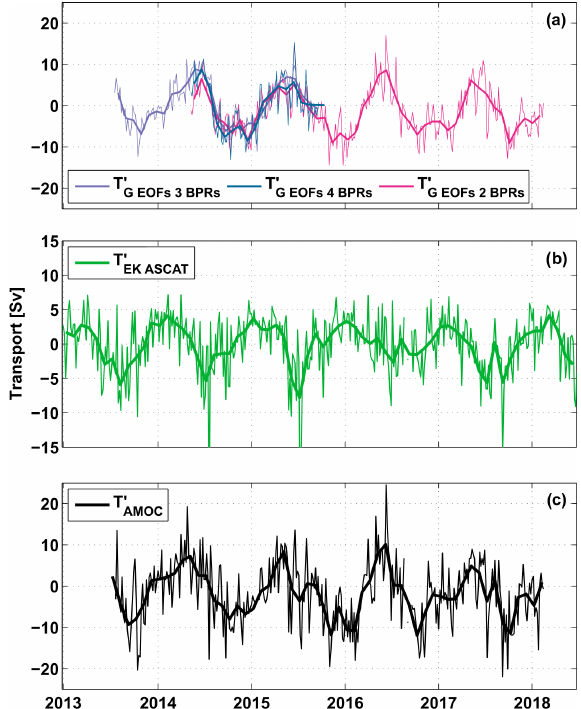
Figure 8. Anomaly time series at 11 ◦ S of (a) the upper-ocean ) , (b) the Ekman transport derived geostrophic transport ( T (cid:48) GEOFs ) and (c) the resulting AMOC from ASCAT wind stress ( T (cid:48) EKASCAT ) . Thin lines represent daily values in panel (a) transport ( T (cid:48) AMOC and 5d values in panels (b, c) ; bold curves represent monthly av- erages. Different colours in panel (a) indicate transport calcula- tions for different sets of BPRs – four BPRs (petrol), three BPRs (500m WB, 300m EB, 500m EB; purple) and two BPRs (300 and 500m WB; magenta) combined with the annual and semi-annual harmonics derived from the fully equipped period (May 2014– October 2015; see Sect.